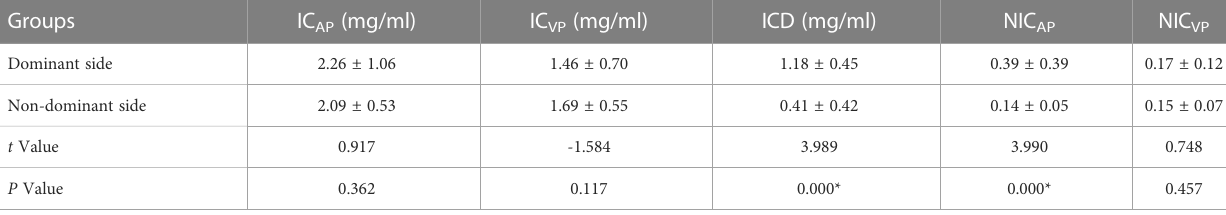
TABLE 2 Comparison of energy parameters on the dominant and non-dominant side of the iodine distribution map.